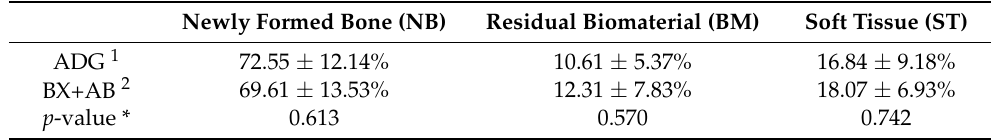
Figure 1. Representative photomicrographs of biopsies taken four months after alveolar ridge preservation. ( A ) shows details of the bone augmented with autologous dentin graft (ADG), whereas ( B ) shows details of bovine xenograft mixed with autologous bone. In both groups, the remaining biomaterial particles (BM and blue arrows in ( B )) are in close contact with the newly formed bone (NB). NB has a regular, lamellar appearance in both groups and is filled with osteocytes (black fill triangles) embedded in lacunae. Osteoblasts (red arrows) are clearly visible at the margins of NB. The soft tissue areas (ST) are rich in cells, especially fibroblasts (no fill triangles). No inflammatory tissue reaction was detected in either group (hematoxylin-eosin, 100 × magnification). Table 3. Histomorphometrical results.